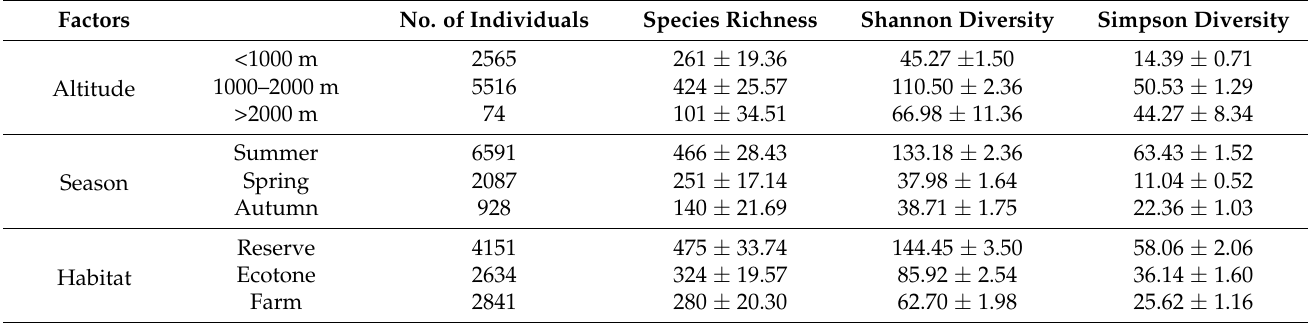
Table 2. Butterfly diversity communities at different altitudes and in different seasons and habitats in the middle Qinling Mountains. Species richness and Shannon and Simpson diversity indices were estimated based on Hill numbers (q = 0, q = 1 and q = 2, respectively; mean ±